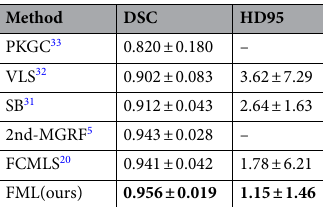
Table 2. Comparison between the segmentation accuracy of the FML method and previous methods. Significant values are in [bold].